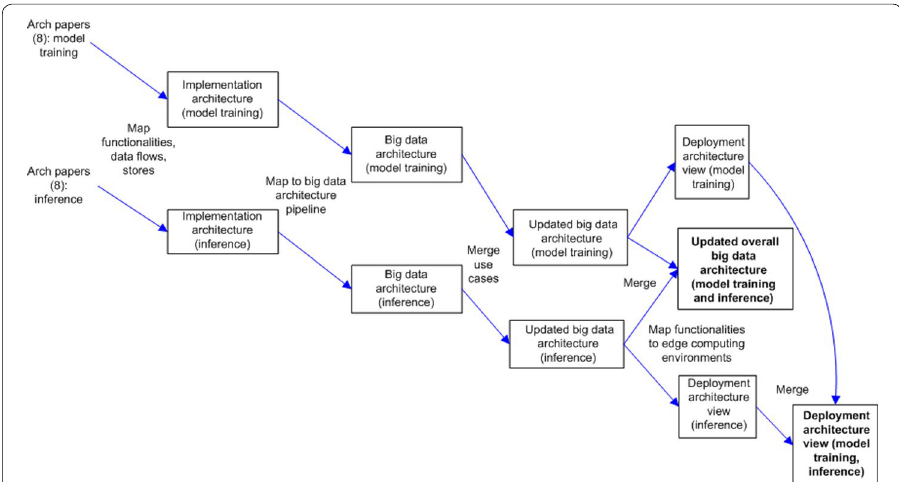
Fig. 2 Construction of RA based on realised implementation